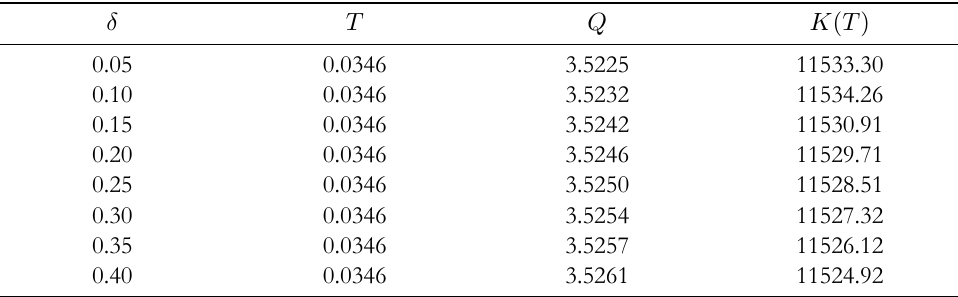
Table 8: Variation in T , Q & K ( T ) with salvage coefficient ( (cid:14) )